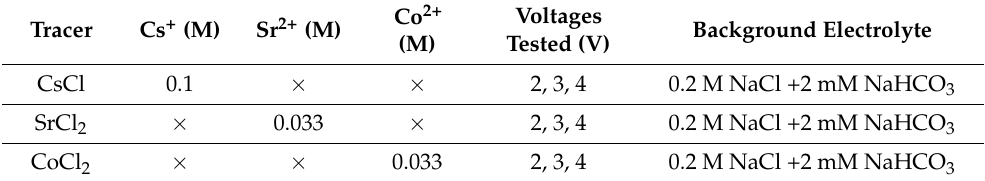
Voltages Co 2+ Background Electrolyte Tested (V) (M)